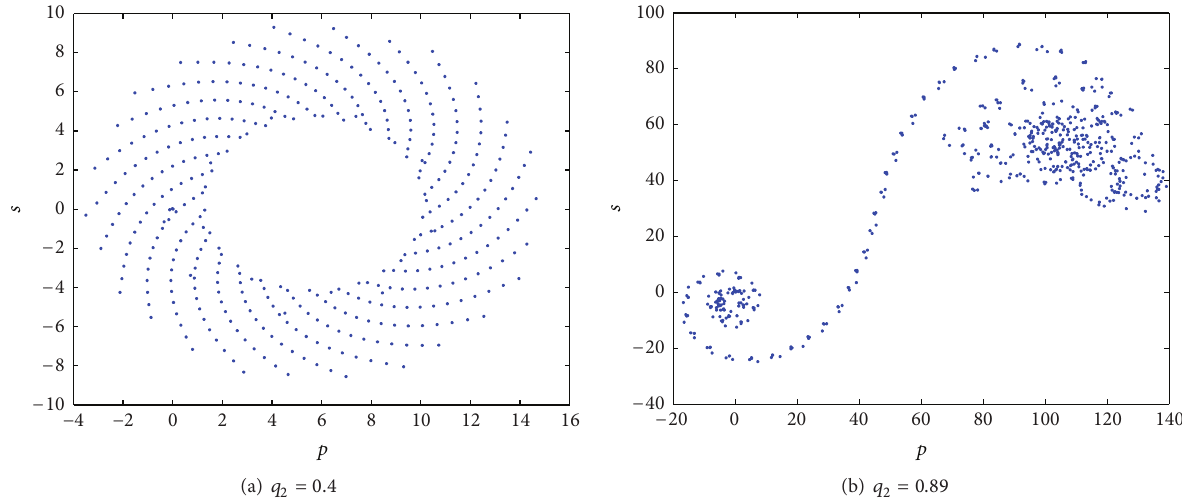
Figure 6: Plots in new coordinates (𝑝,𝑠) space with 𝑞 1 = 0.98 , 𝑞 3 = 0.97 , 𝑞 4 = 0.78 , 𝑎 = 3 , 𝑏 = 0.4 , 𝑐 = 0.4 , and 𝑑 = 0.1 .